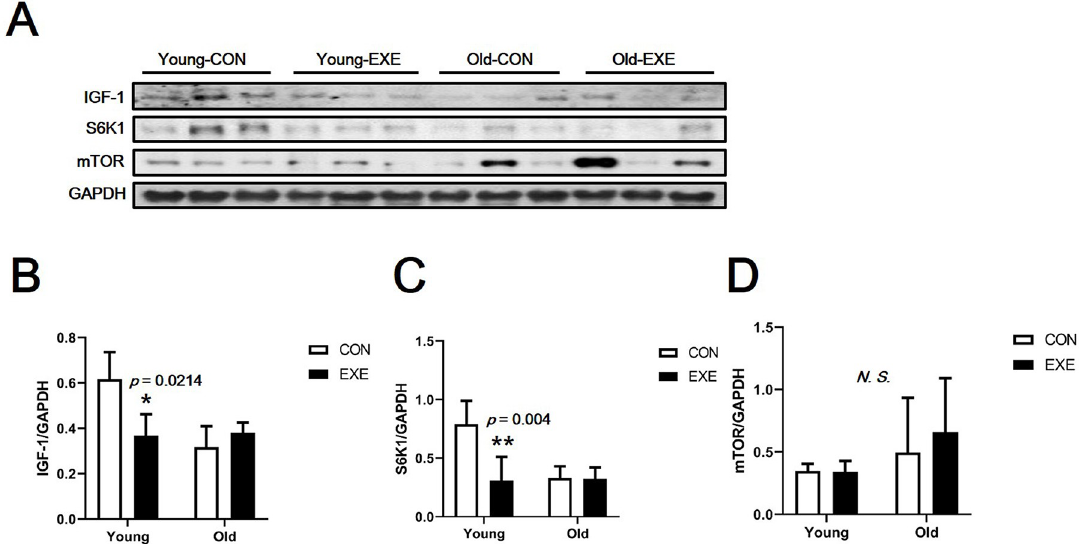
Fig 4. Expression of skeletal muscle synthesis-related proteins in mice subjected to LSE. (A) Western blotting band images (results of skeletal muscle synthesis-related protein analysis). (B) IGF-1 expression level. (C) S6K1 expression level. (D) mTOR expression level. All data are presented as the mean ± SD vs. control group of same age, † p < 0.05 and ‡ p < 0.01.